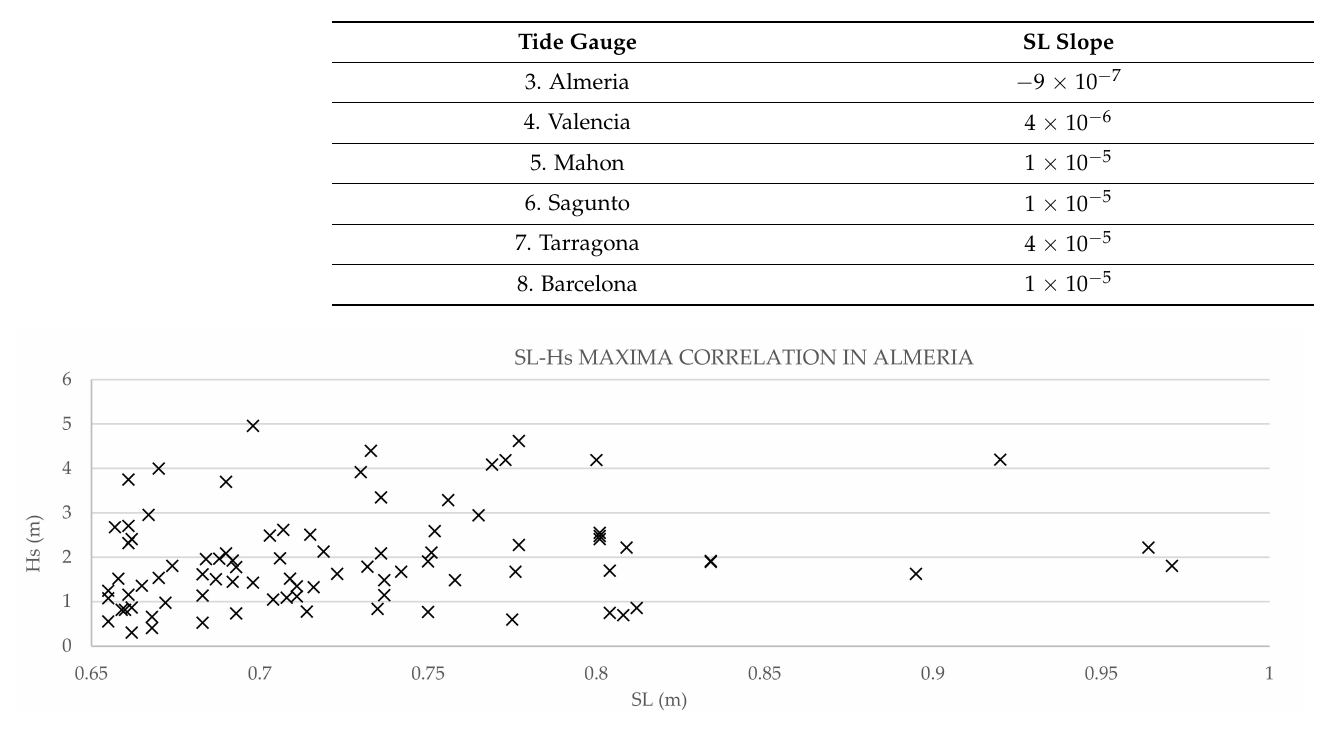
Figure 41. Correlation of extremes in Almeria.